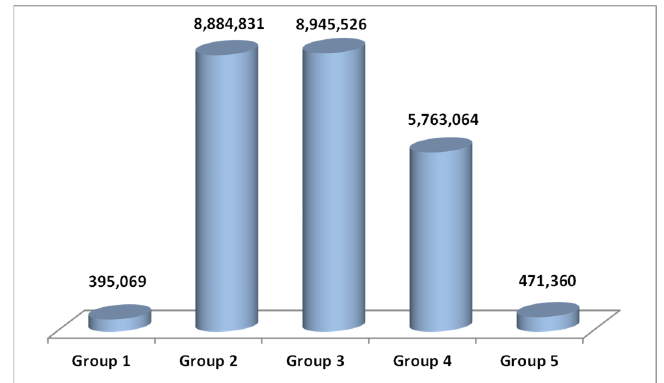
Figure 1. Number of cities of each group.